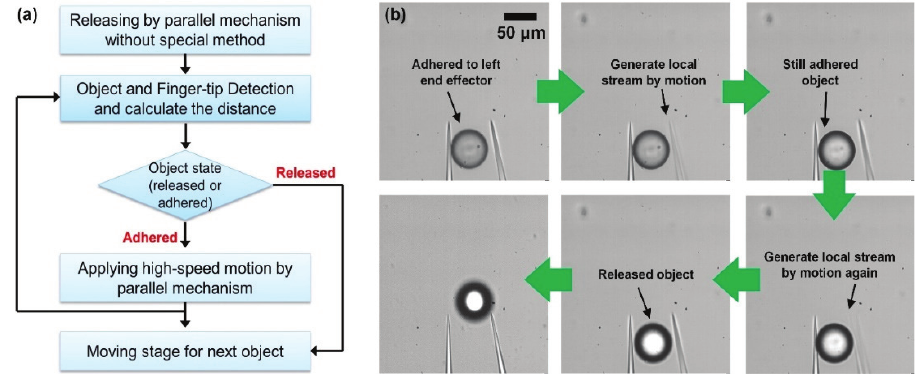
Figure 7. Releasing process for improving success rate. ( a ) Flowchart; ( b ) Image sequence of releasing process.